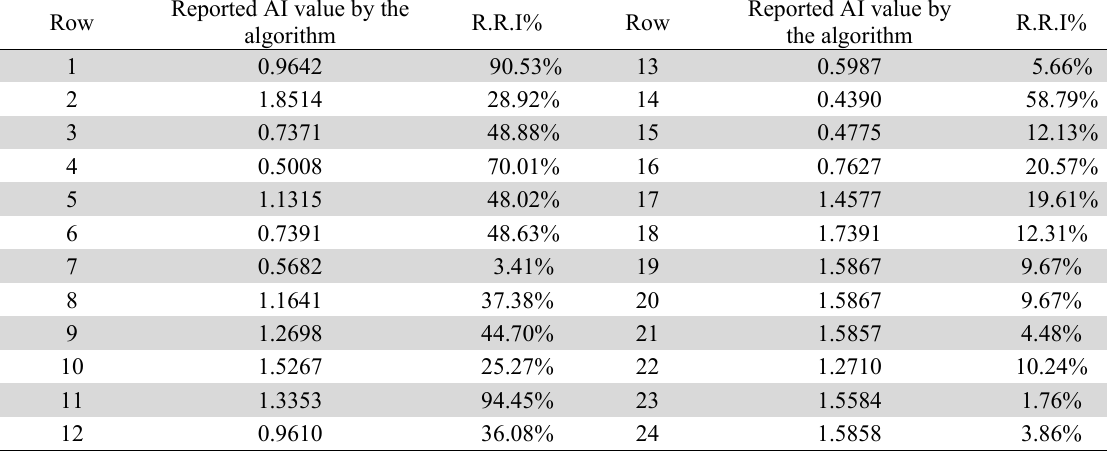
The results of RPI% for studies while solved by the proposed method